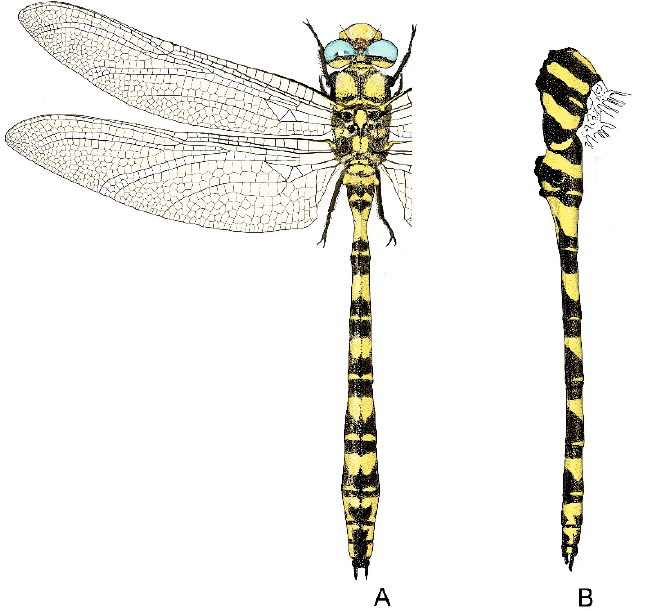
Figure 14. Cordulegaster charpentieri, (dark form) ♂ , (in coll. Elias and Thomas Schneider, leg. Thomas Schneider, 28 May 2014, Iran Dalfard, 29.0022° N, 57.5869° E, 2110 m a.s.l.): ( A ): habitus, dorsal. ( B ): habitus, lateral.